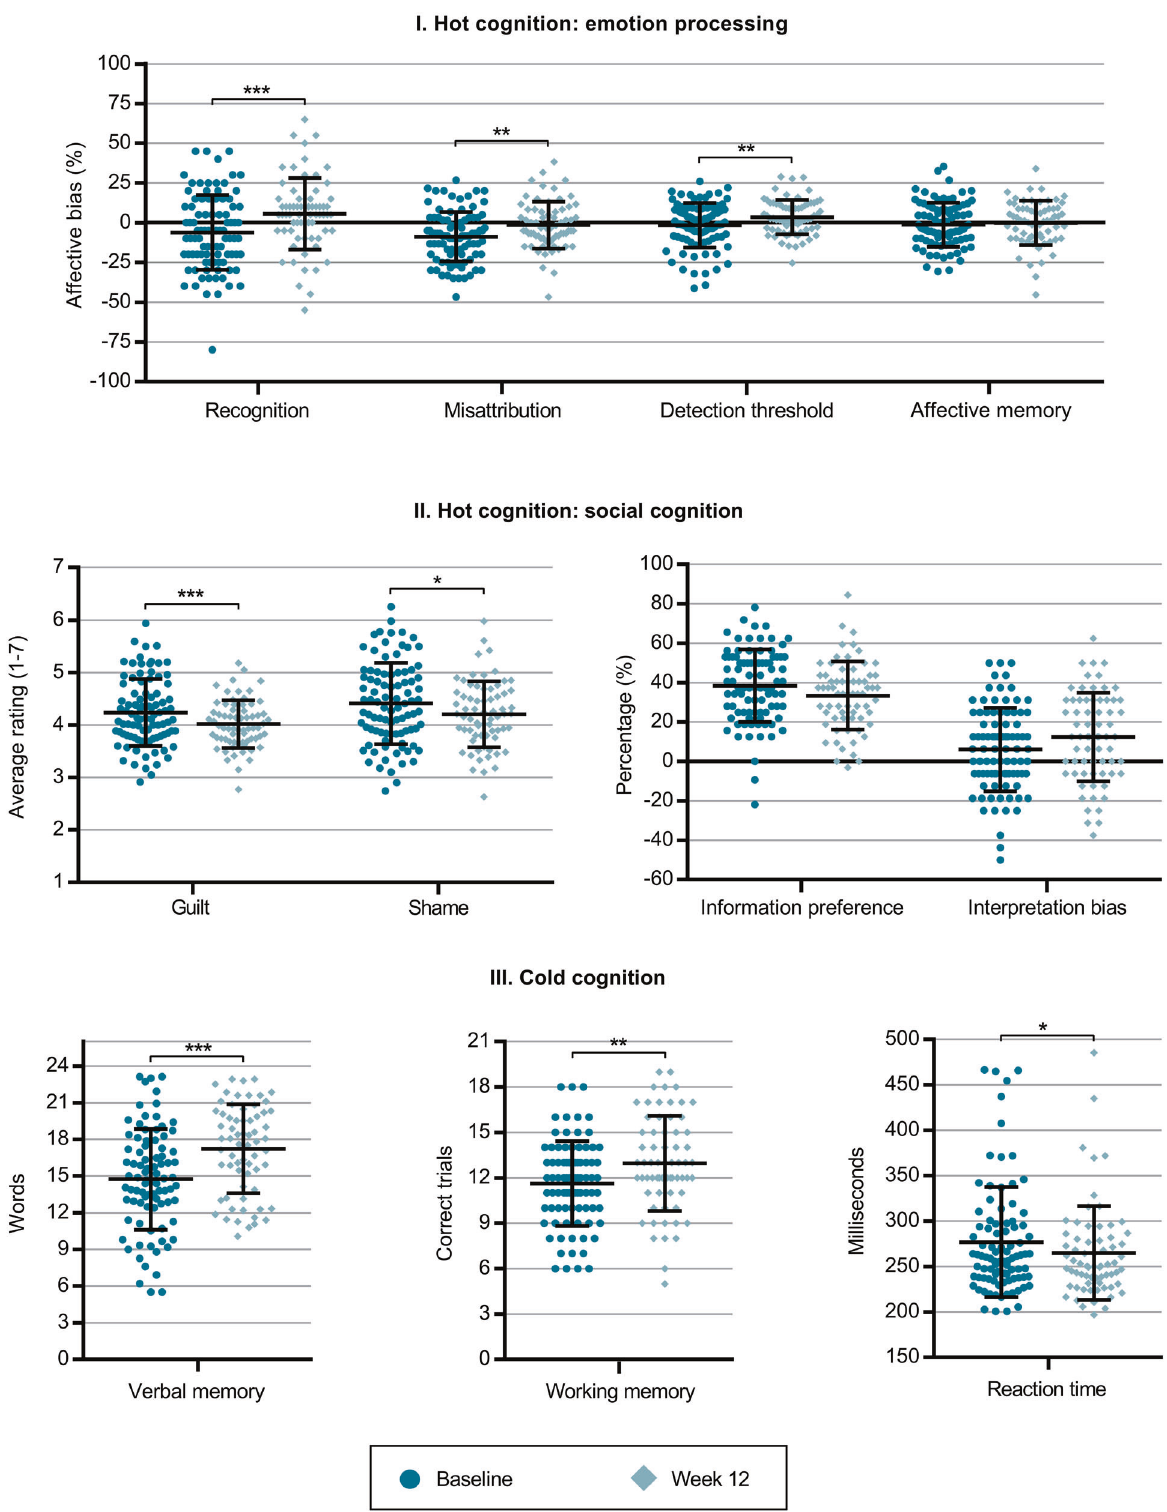
across several cognitive domains may provide a stronger predictive construct. In the large iSPOT-D trial (baseline, N = 1008; completers, N = 665), two patient subgroups were identi fi ed using cluster analysis: a large group (~75%) with intact cognitive functions and a smaller (~25%) with broadly